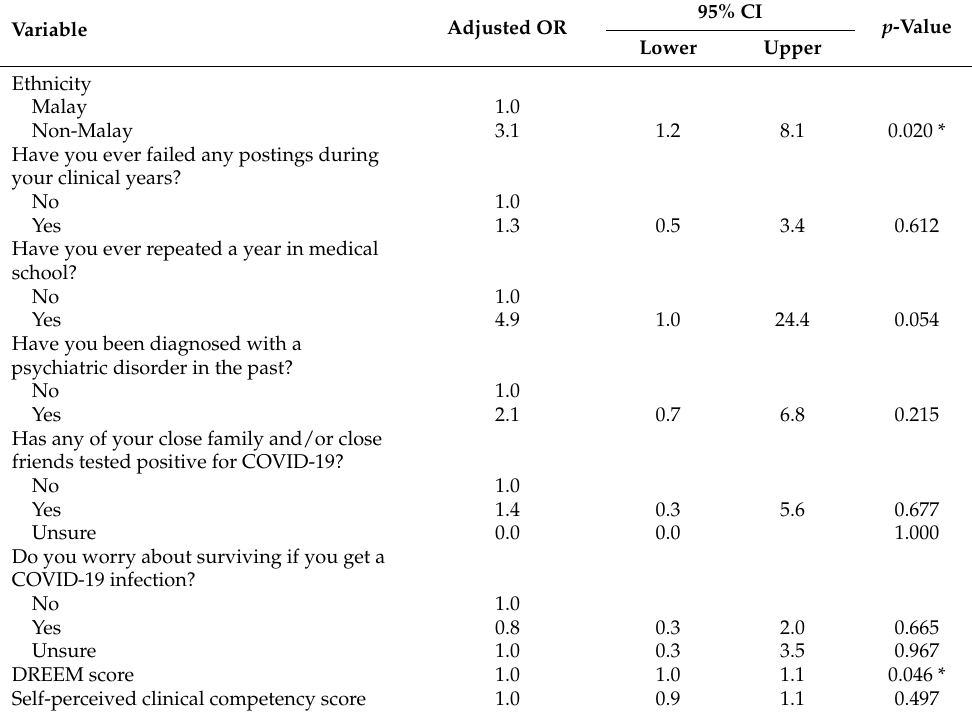
Table 5. Logistic regression analysis for factors associated with